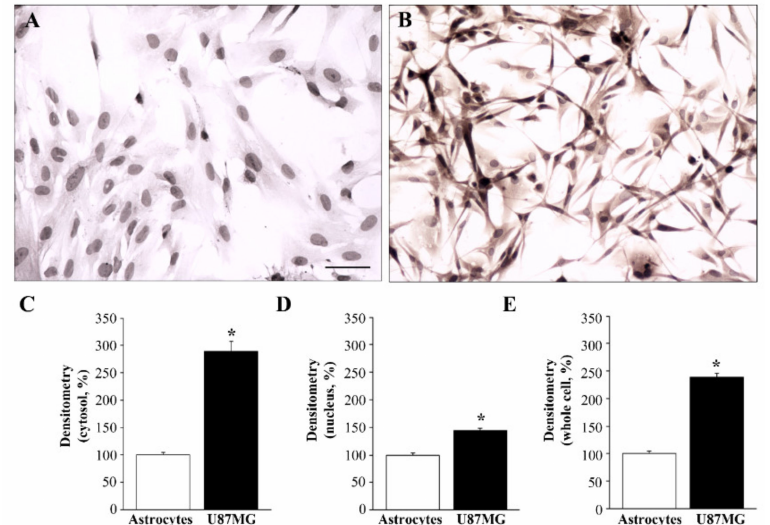
Figure 1. Differential expression of α -syn immuno-cytochemistry between astrocytes and U87MG cells. Representative pictures of α -syn immuno-cytochemistry within astrocytes ( A ) compared with U87MG cells ( B ). Immuno-peroxidase shows that, in baseline conditions, U87MG cells exhibit marked α -syn immunoreactivity in the cytosol, whereas α -syn immunostaining is barely detectable within the cytosol of astrocytes. Graphs report the densitometry of α -syn staining within the cytosol ( C ), nucleus ( D ), and whole cell ( E ) for α -syn staining within astrocytes, compared with GBM cells. Data are given as the mean percentage ± SEM of optical density in each experimental group (assuming the astrocytes to be control = 100% density) obtained from n = 30 cells (astrocytes or U87MG cells), in N = 3 independent experiments. * p < 0.05 compared with astrocytes. Scale bar = 32.5 µ